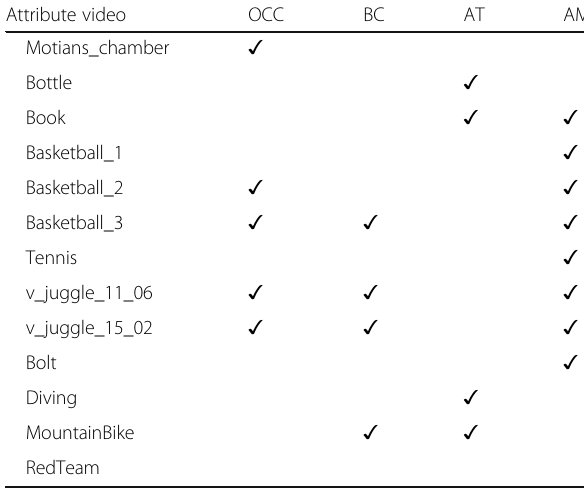
Table 3 Video sequences with different attributes